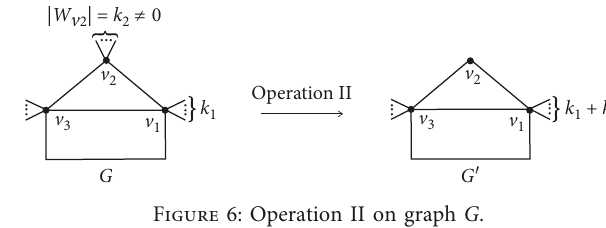
Figure 6: Operation II on graph G